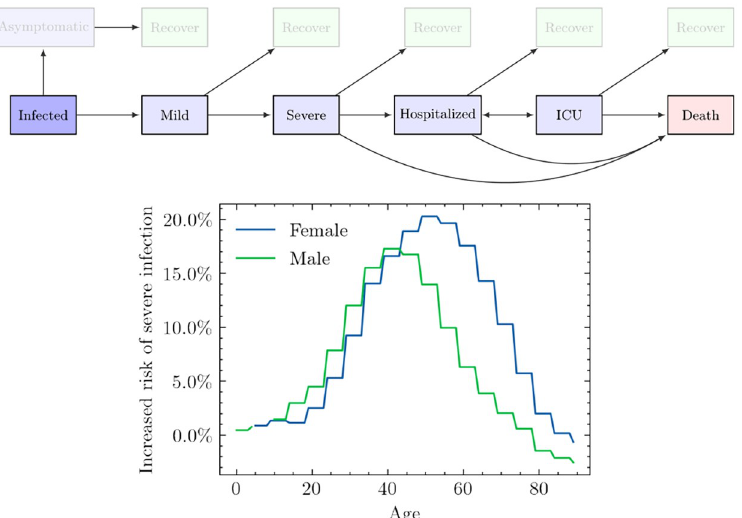
Fig 3. Upper: Modeled health trajectories. When an individual is infected, they might remain asymptomatic, or become symptomatic with symptoms likely to progress. In our implementation, the likelihood of each of these transitions is dependent on the age, sex, and/or comorbidities of the infected individual. As more data becomes available, additional factors can also be included. Lower: Severe infection rates adjusted for estimated comorbidities in the PoC population using UK data as a baseline. We show the increased risk of severe infection due to the presence of comorbidities, r c (age, sex), defined as, P Cox (severe | age, sex) = P UK (severe | age, sex)(1 + r c (age, sex)). Note that although r (age, sex) decreases for the oldest age groups, P UK (severe | age, sex) increases exponentially with age and c therefore the older an agent is, the more likely it is for them to develop a severe infection.